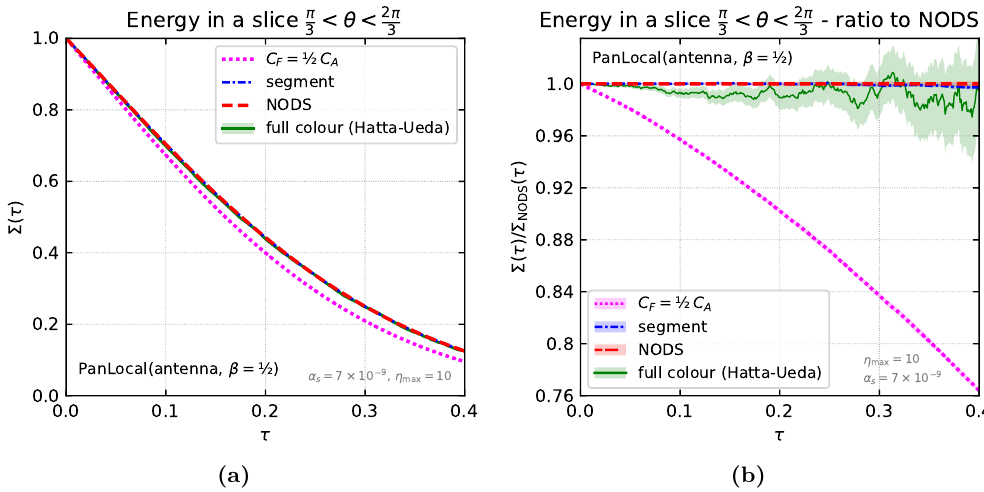
Figure 12. NLL (single-logarithmic) tests for a non-global observable. (a) Fraction of events whose energy flow in a central slice of rapidity is less than e −| L | Q , shown in the limit α for fixed α , as a function of τ ( α ) , defined in eq. (7.10). Our results are shown for the s L s , L PanScales antenna shower with β = 1 / 2 , with three different colour schemes: leading- N PS C F = C A / 2 = 3 / 2 ), segment and NODS. They are compared to the full-colour Hatta-Ueda